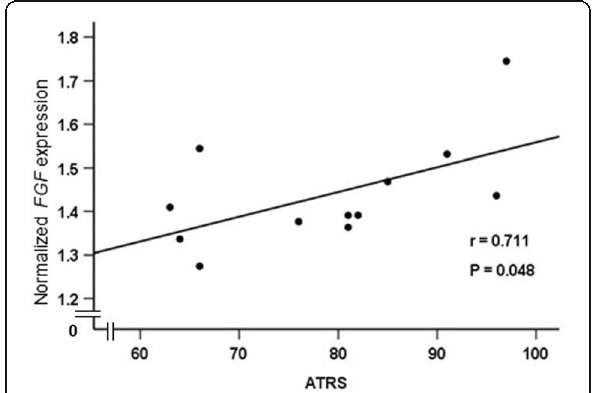
Fig. 2 Correlation between FGF mRNA expression and total ATRS as measured by Spearman ’ s rank correlation coefficient. FGF mRNA expression was normalized and ATRS ranges from 0 to 100, with 100 = best outcome. n =